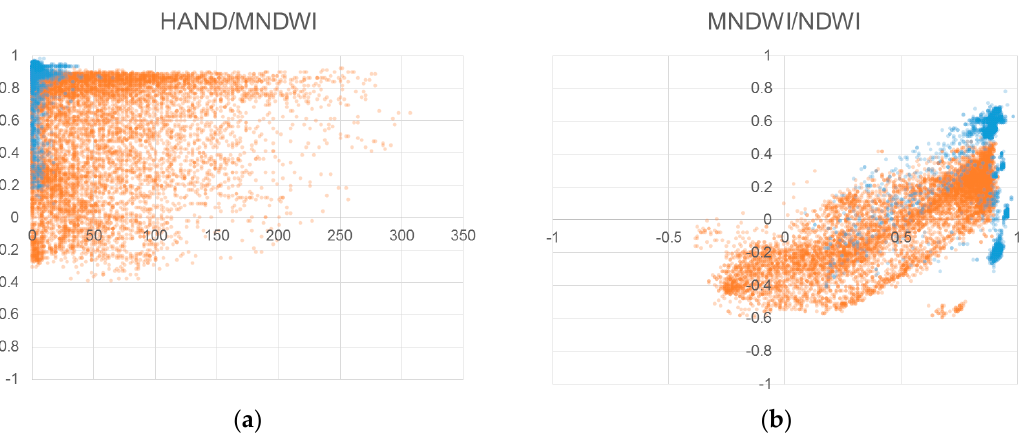
Figure 12. Values of HAND vs. MNDWI ( a ) and MNDWI vs. NDWI ( b ) used during training of the CART classifier. Orange and blue dots represent land and water, correspondingly.